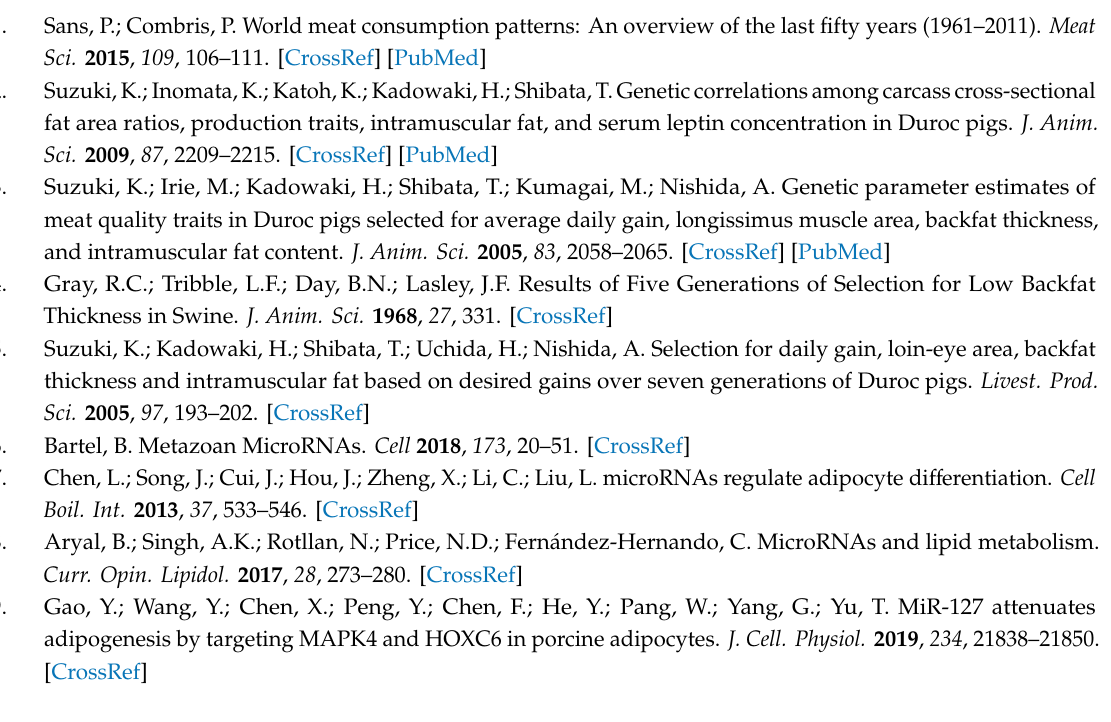
Table S1: Age, weight, backfat thickness and pedigree information; Table S2: Summary of RNA-seq data alignment; Table S3: miRNA count in each sample; Table S4: Di ff erentially expressed miRNAs between individual pigs in each pair of siblings; Table S5: Potential target genes predicted by miRDB and Targetscan; Table S6: Diiferentially expressed genes between HB and LB